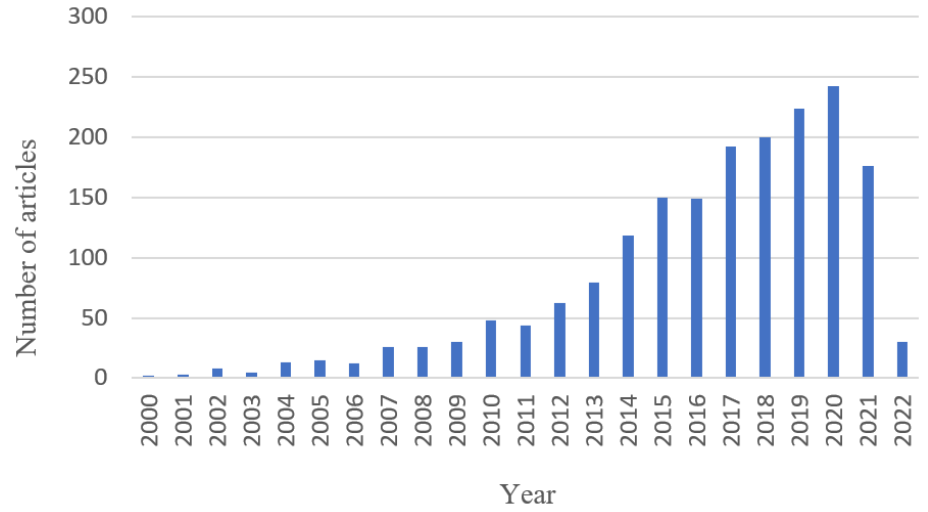
Figure 1. Article record 2000–2022 in Web of Knowledge (WOK).